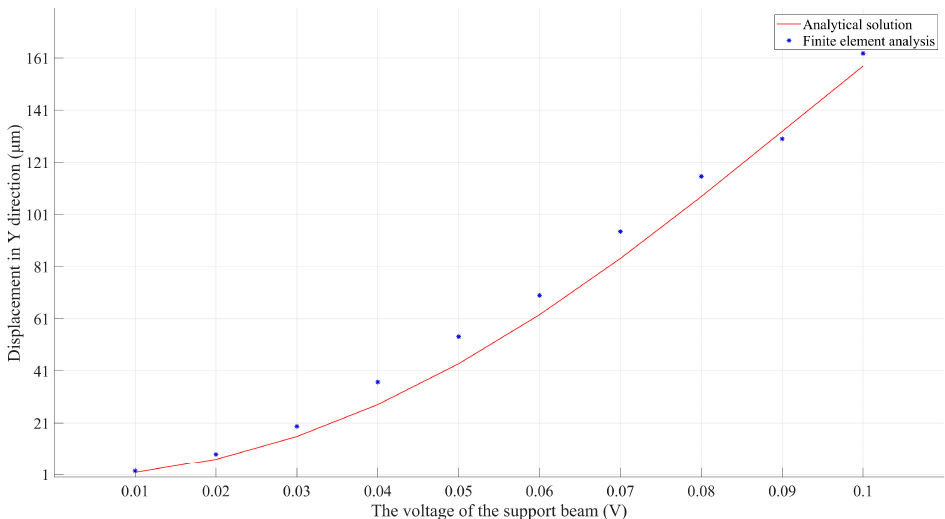
Figure 11. Comparison of the analytical solution and the FEA results for the Y-displacement of the microrobotic solar sail over a wide range of supply voltages.